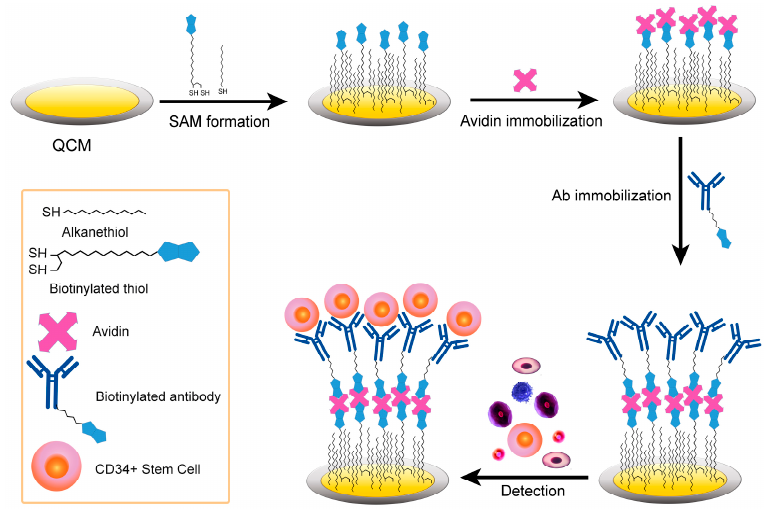
Figure 1. Schematic illustration of the quartz crystal microbalance (QCM) immunosensor for the detection of CD34+ stem cells.